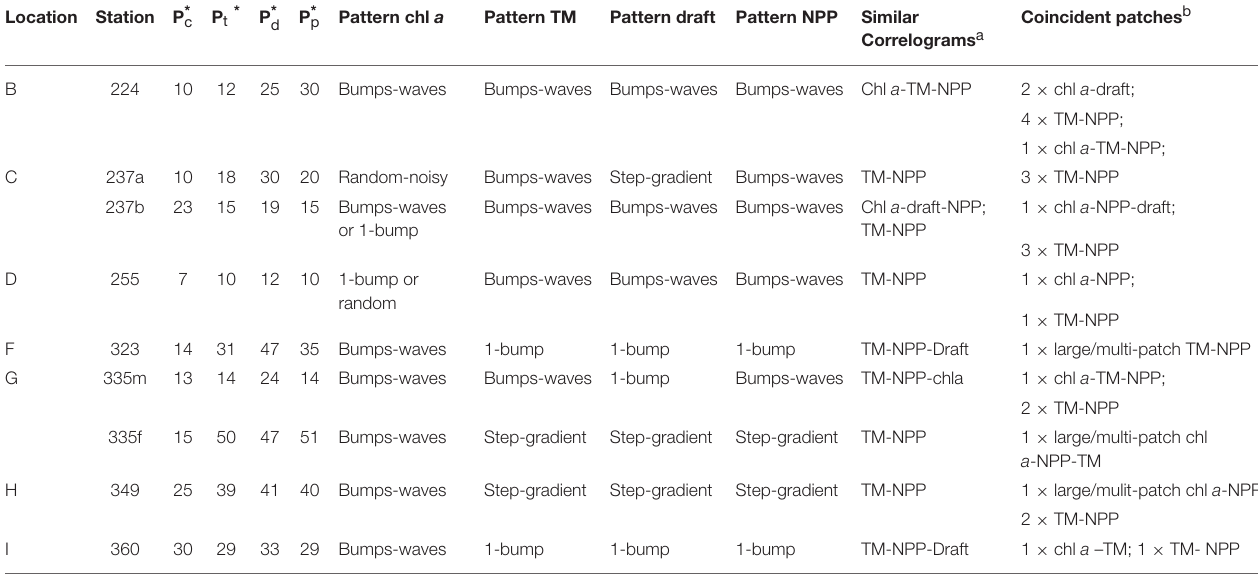
TABLE 6 | Summary of the autocorrelation analyses per location and ROV